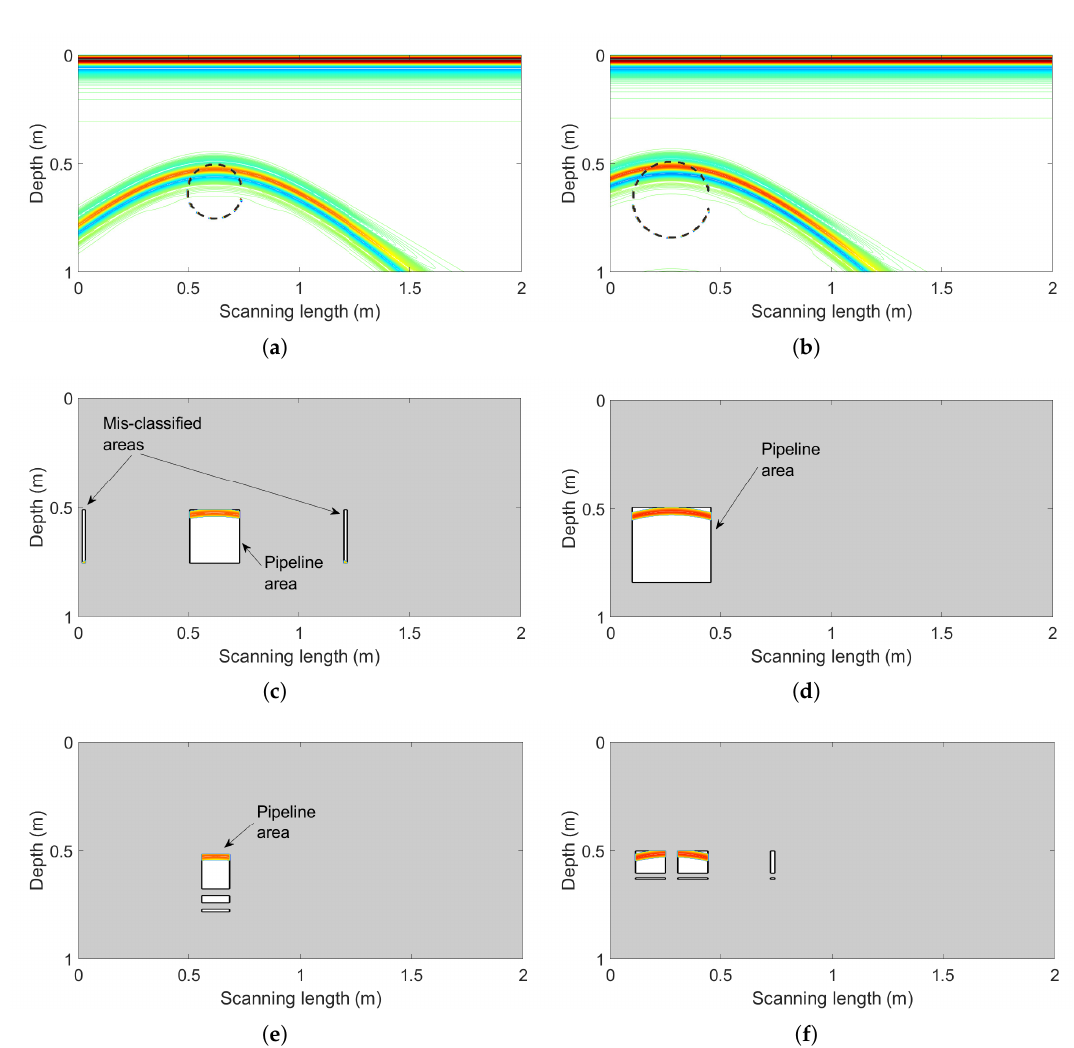
Figure 9. ( a ) The example input profile with a single pipeline (central coordinates (0.615 m, 0.63 m), diameter 0.25 m). ( b ) Another example input profile with a single pipeline (central coordinates (0.275 m, 0.667 m), diameter 0.35 m). ( c ) The reconstructed profile of panel (a) by the proposed learning framework. ( d ) The reconstructed profile of panel (b) by the proposed learning framework. ( e ) The reconstructed profile of panel (a) after the independent SVM for comparison. ( f ) The reconstructed profile of panel (b) after the independent SVM for